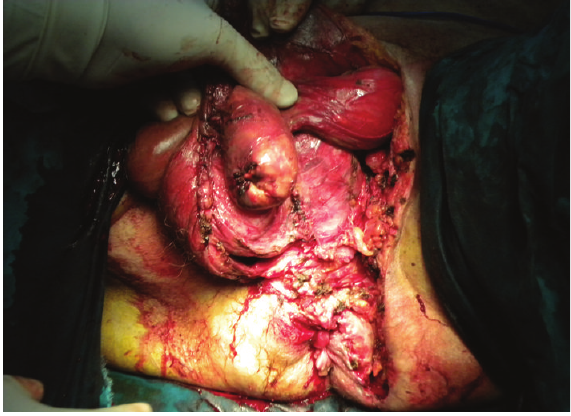
Figure 3: Wide-open drainage of the necrotic skin in the scrotum and perineal